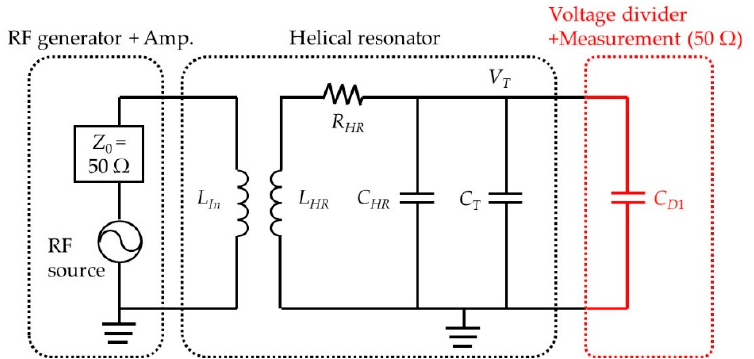
Figure 6. Simplified equivalent RF circuit model for our ion trap setup.